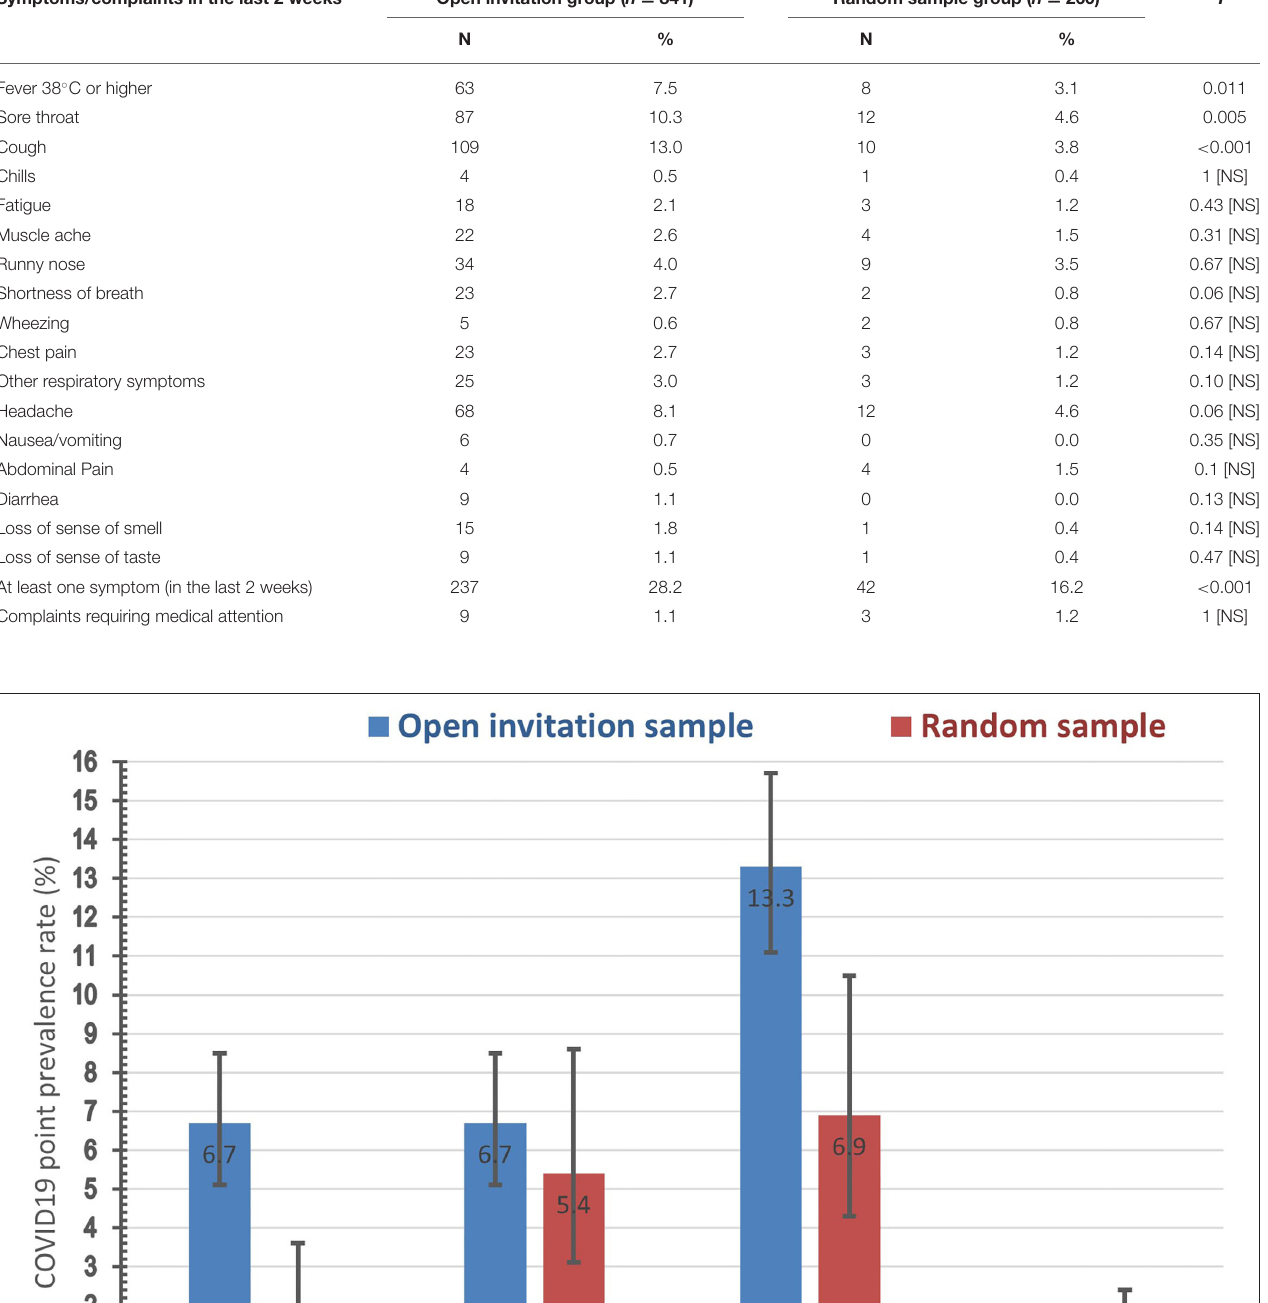
TABLE 2 | The difference in relative frequency of selected symptoms between the two study groups. Symptoms/complaints in the last 2 weeks Open invitation group ( n = 841) Random sample group ( n = 260)